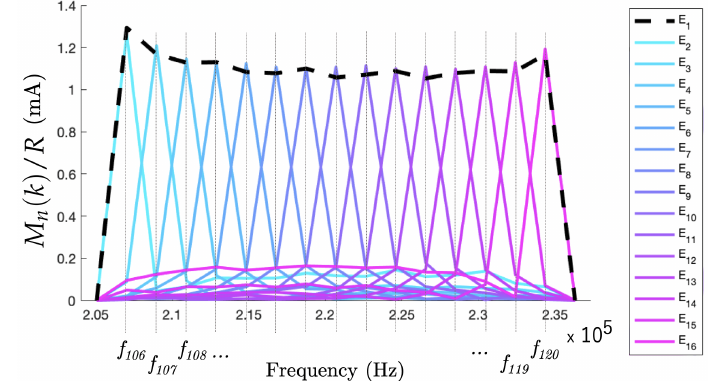
Figure 8. Magnitudes of the DFT from excitations in the high harmonic